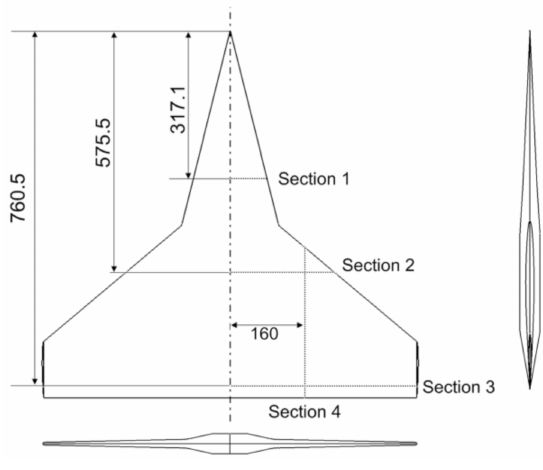
Figure 1. LSSDW model. Table 1. Computing states of